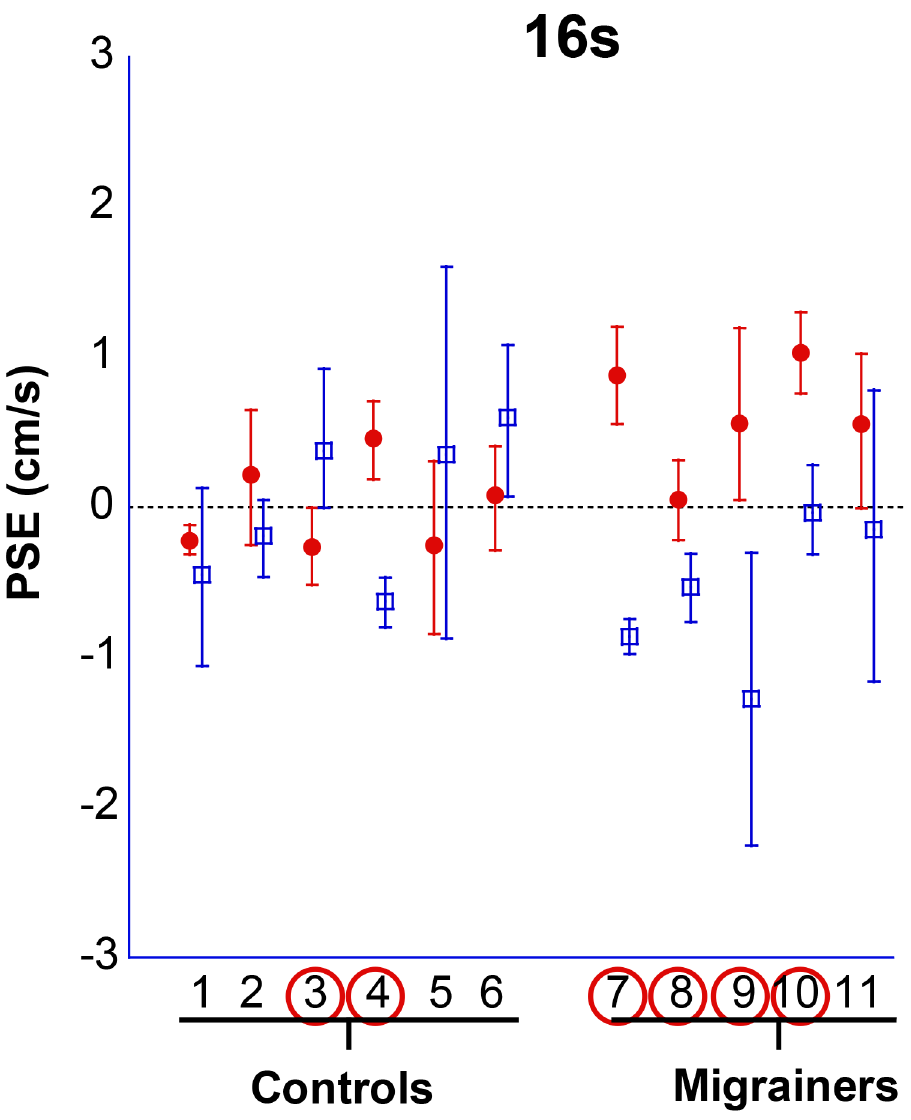
Fig 14. 16s duration VFM stimulus. Individual subject PSE for inertial nulling of visual field motion. Subjects are represented along the x-axis (subjects 1 – 11). Looming VFM trials are represented by solid red symbols; receding VFM trials by open blue symbols. A positive PSE indicates a stationary platform would be likely to be perceived as forwards self-motion. Circled subject numbers indicate a significant difference between these (p < 0.05). Error bars represent 95%